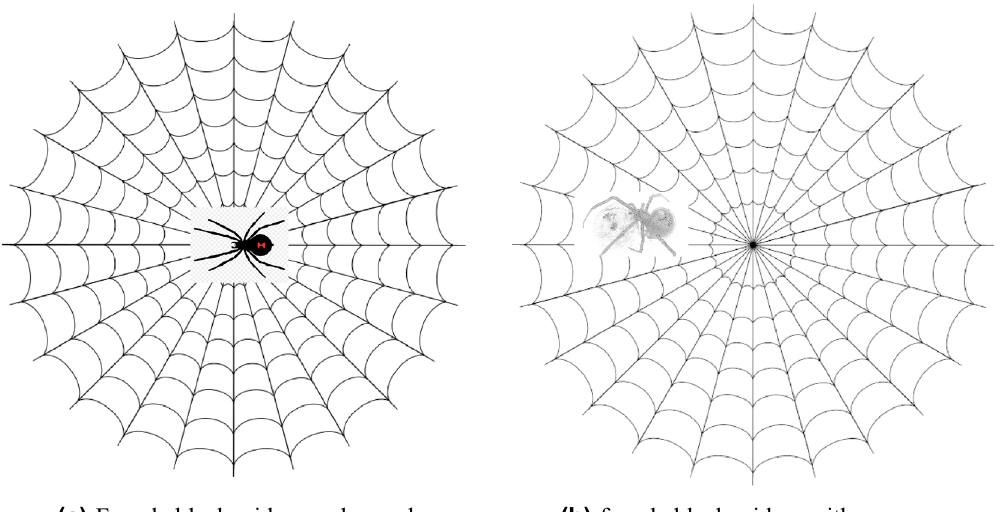
Figure 1. Female black widow representation for web and egg